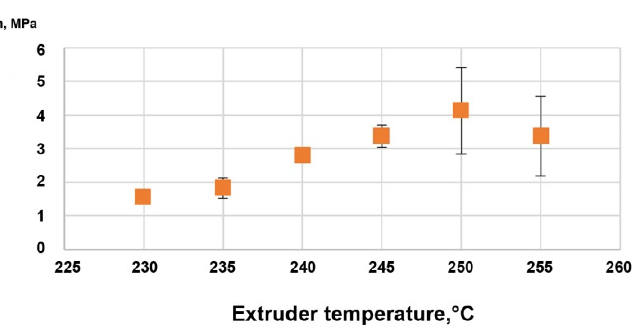
Figure 11. Ultimate tensile strength vs. printing temperature of the PA12-ZrO 2 samples from Batch 1.